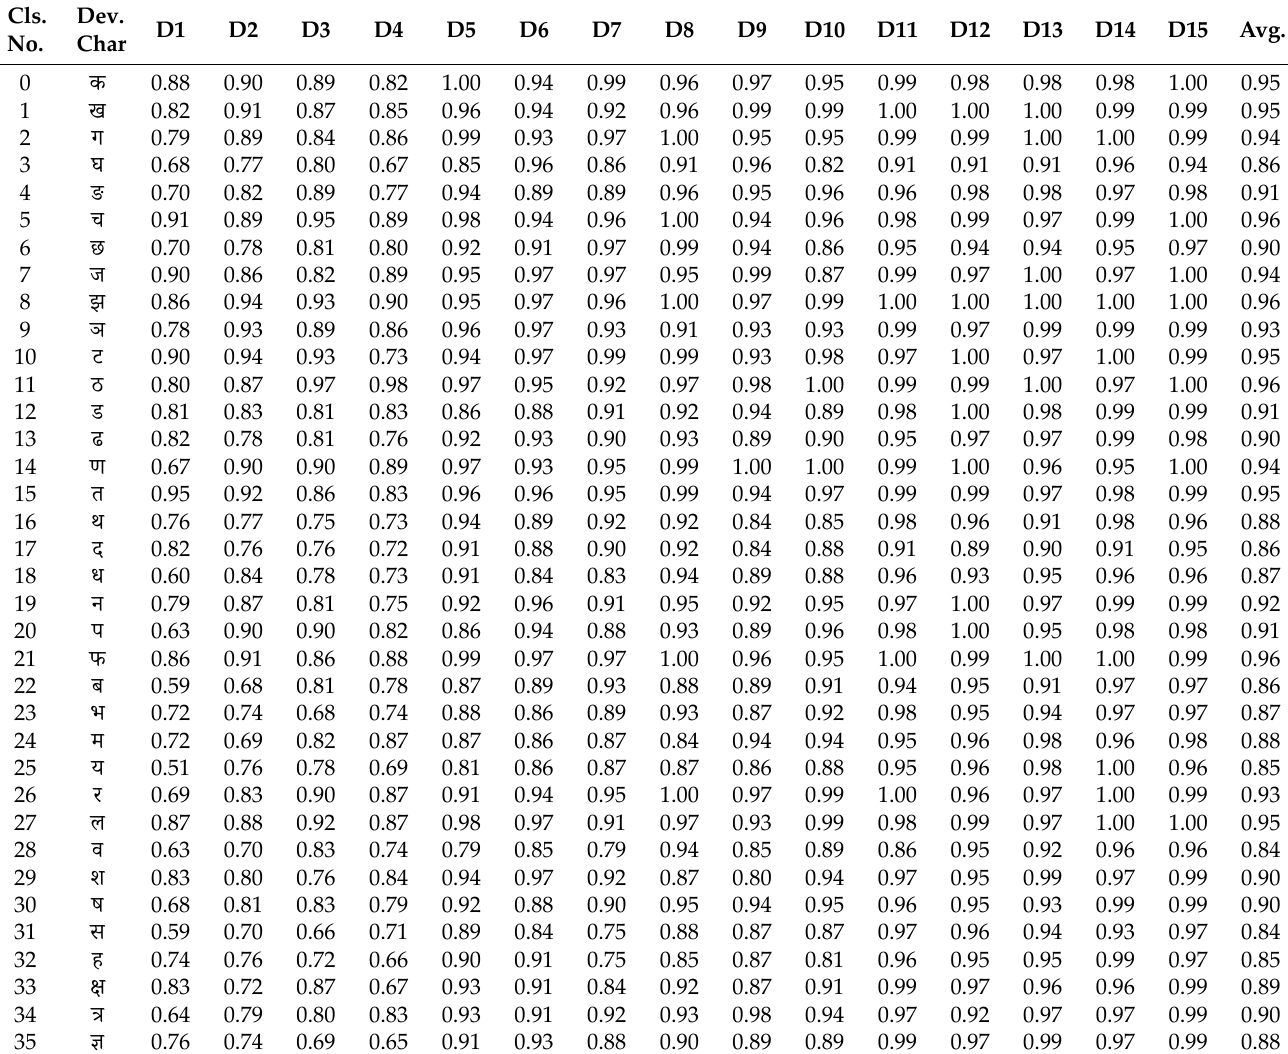
Table 11. Character‑wise recall produced by an SVM classifier for the proposed datasets. Cls.